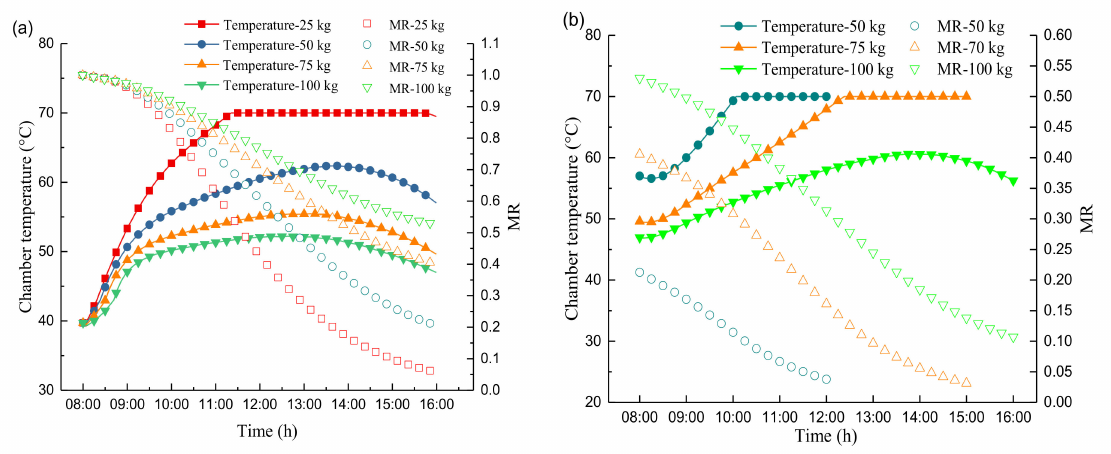
Figure 13. Hourly variations of the chamber temperature and moisture ratio (MR) with a di ff erent drying weight of wolfberry ( a ) on the first day and ( b ) on the second